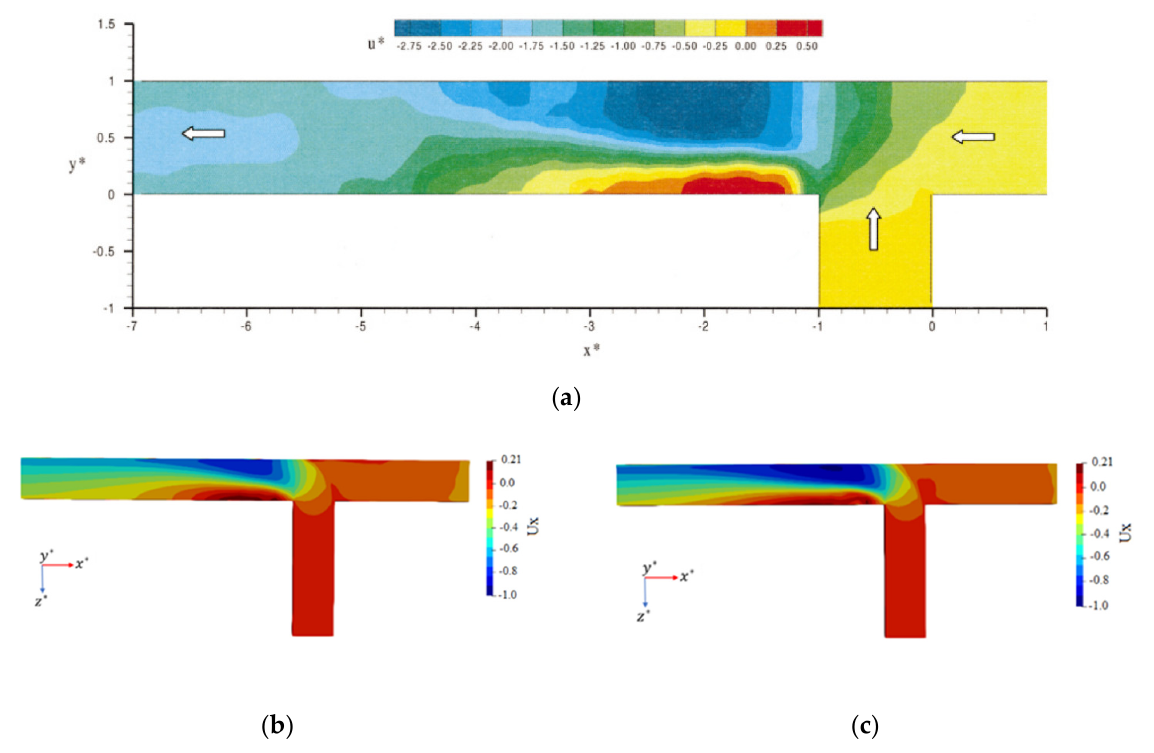
Figure 22. Comparison between experimental data and simulated results for longitudinal velocity. ( a ) Longitudinal velocity contour- experiment (Weber et al., 2001) [19]; ( b ) Longitudinal velocity contour for the open confluent channel (Standard k- ε )- Simulated; ( c ) Longitudinal velocity contour for the open confluent channel (Realizable k- ε )- Simulated.